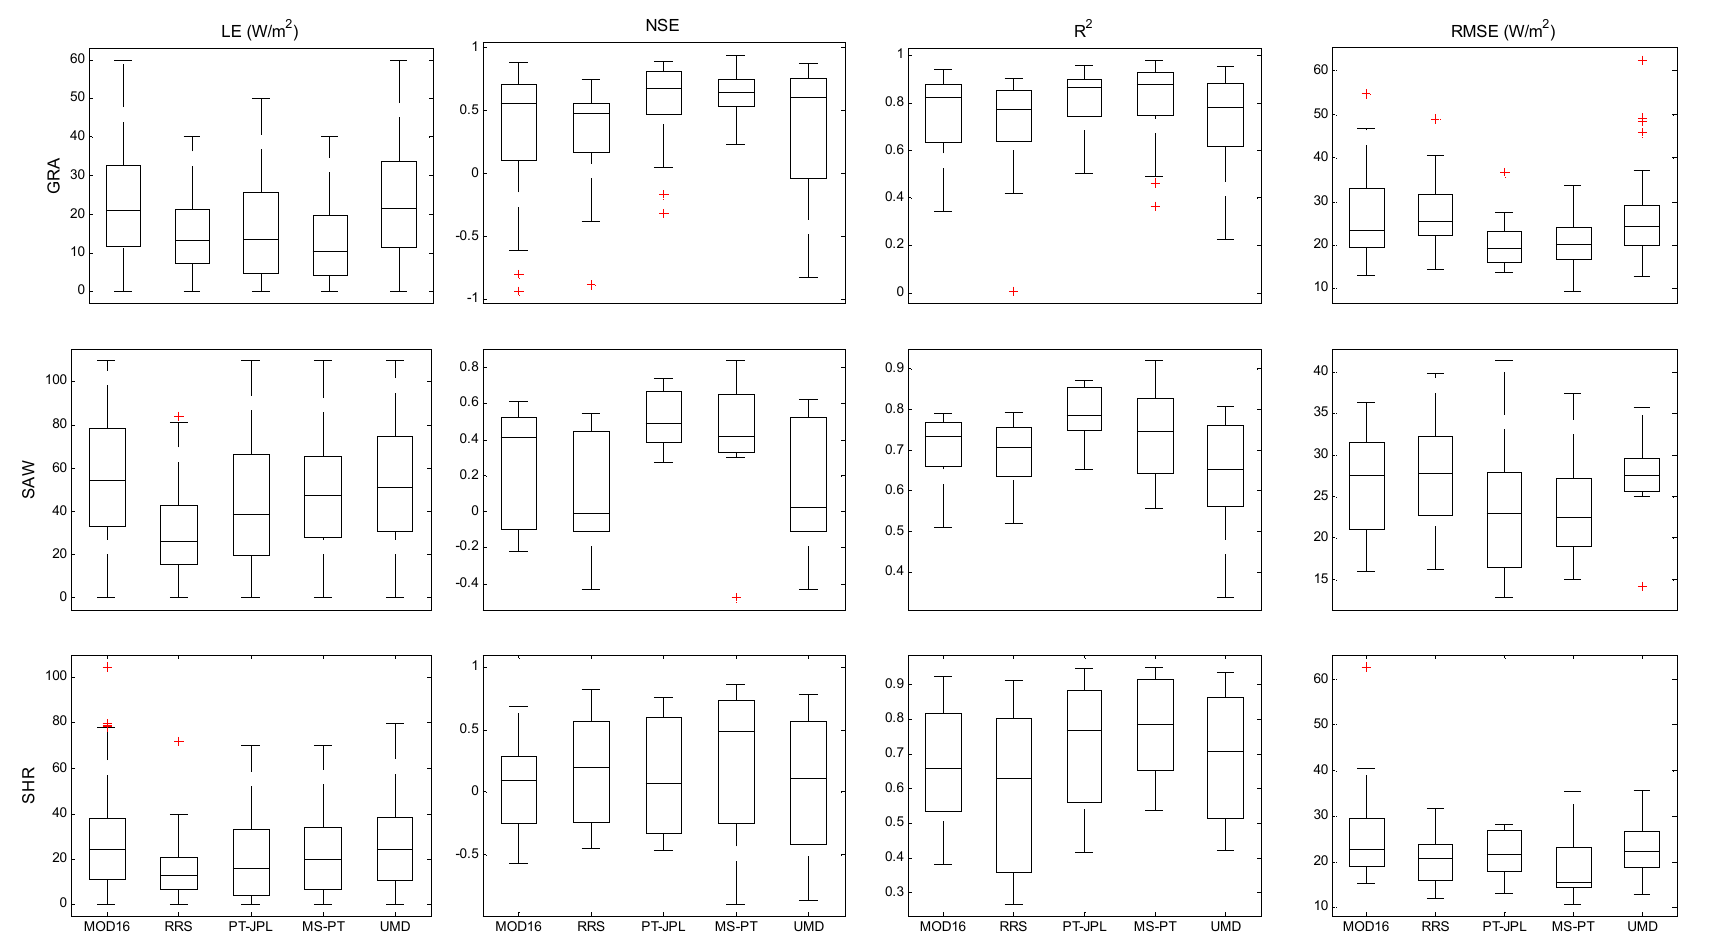
Figure 2. Comparison of statistical indicators including latent heat flux (LE) values, Nash–Sutcliffe efficiency coefficient (NSE), the coefficient of determination (R 2 ) and root mean squared error (RMSE) by daily LE observations and simulations of five LE algorithms at 68 EC sites for GRA (grassland), SAW (savanna), SHR (shrubland) during the period 2000–2009.